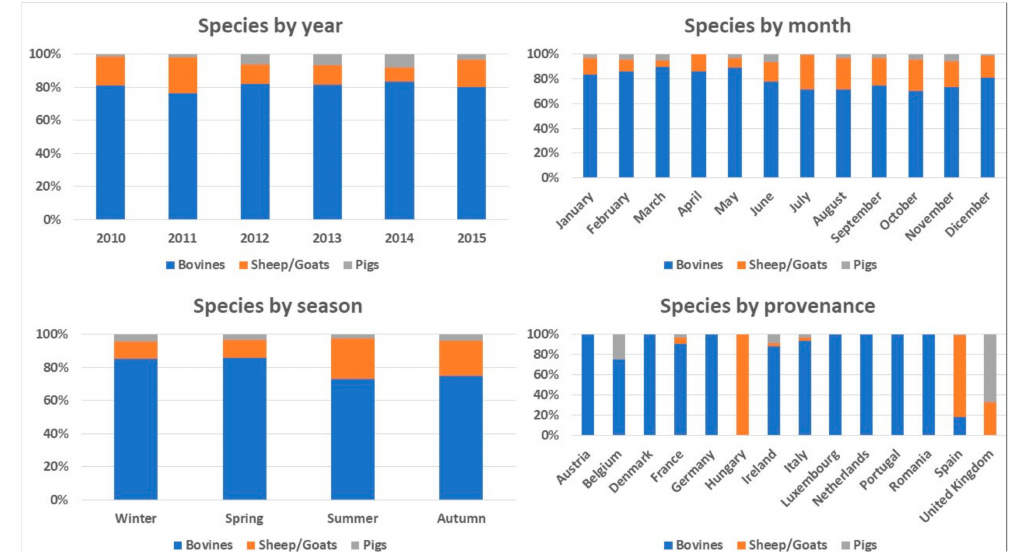
Figure 3. Association between species and year, month, season, provenance, nationality of transport company and